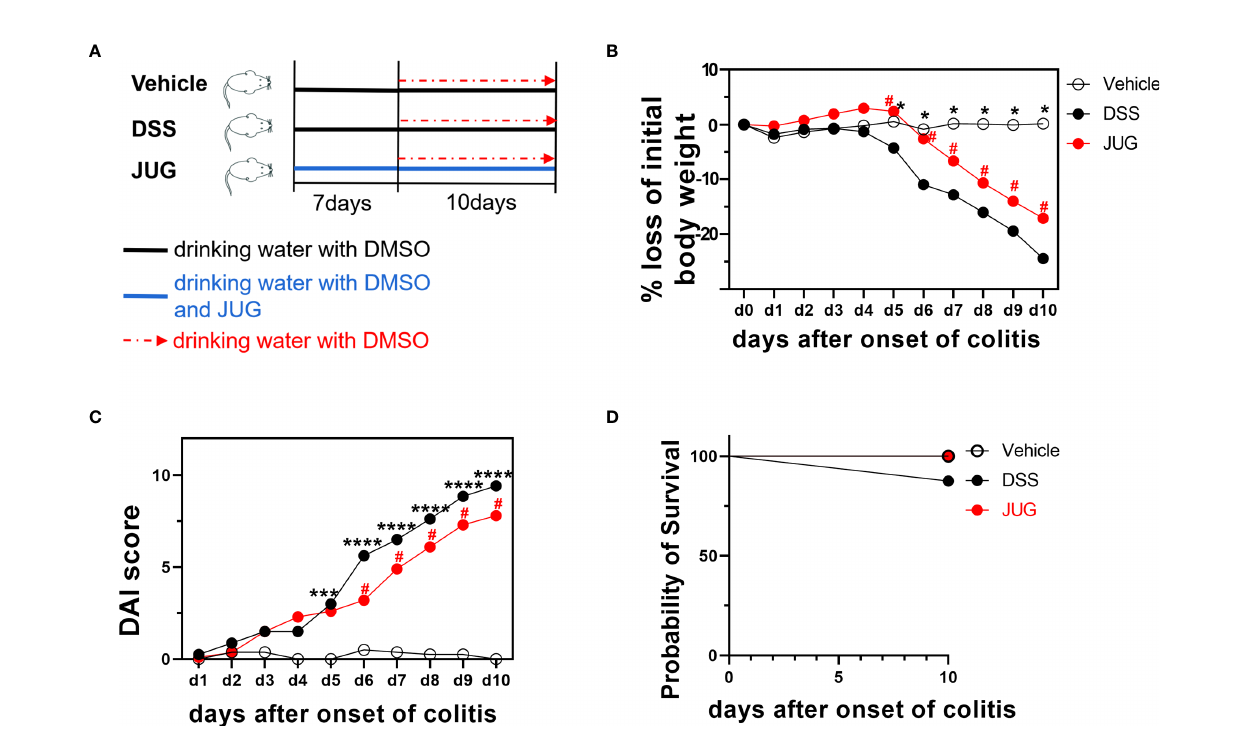
FIGURE 1 | Bodyweight loss, the DAI score, and the survival probability of mice. (A) Schematic showing the treatment of each group. Bodyweight loss percentage (B) , DAI score (C) , and survival probability (D) during the DSS administration. Two-way ANOVA was used to analyze the difference between the DSS group and the vehicle/JUG group. * P < 0.05, *** P < 0.001, **** P < 0.0001, # P <